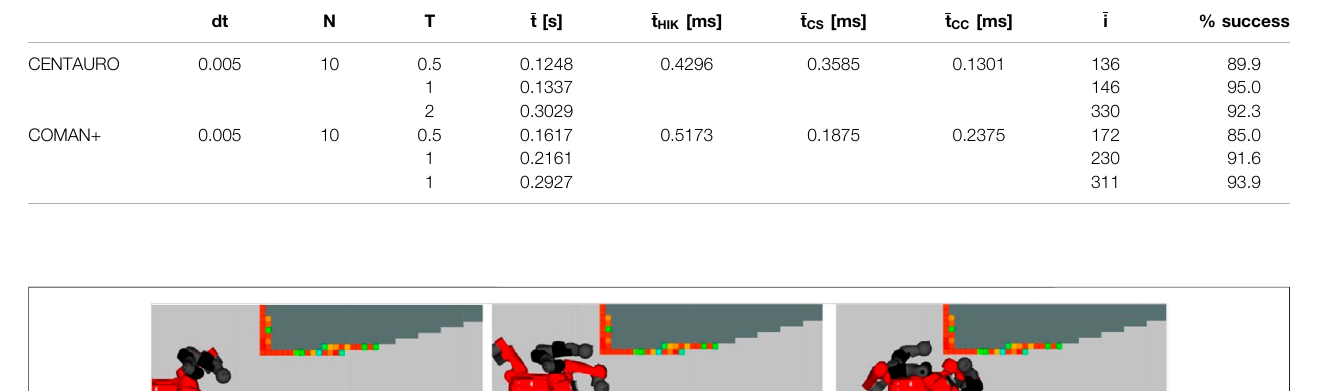
TABLE3| Resultsfromthescenarioin Section6.2 :dt,N,andTarethethreeparametersoftheNSPG,and t HIK , t CS ,and t CC aretheaveragetimerequiredbytheHIKsolver, thecentroidalstatics, and thecollision check, respectively, averagedonthe threeexperiments, which donot depend ontheparameter T.Theaverage number ofNSPG iterations to fi nd a feasible solution is shown in the second last column.